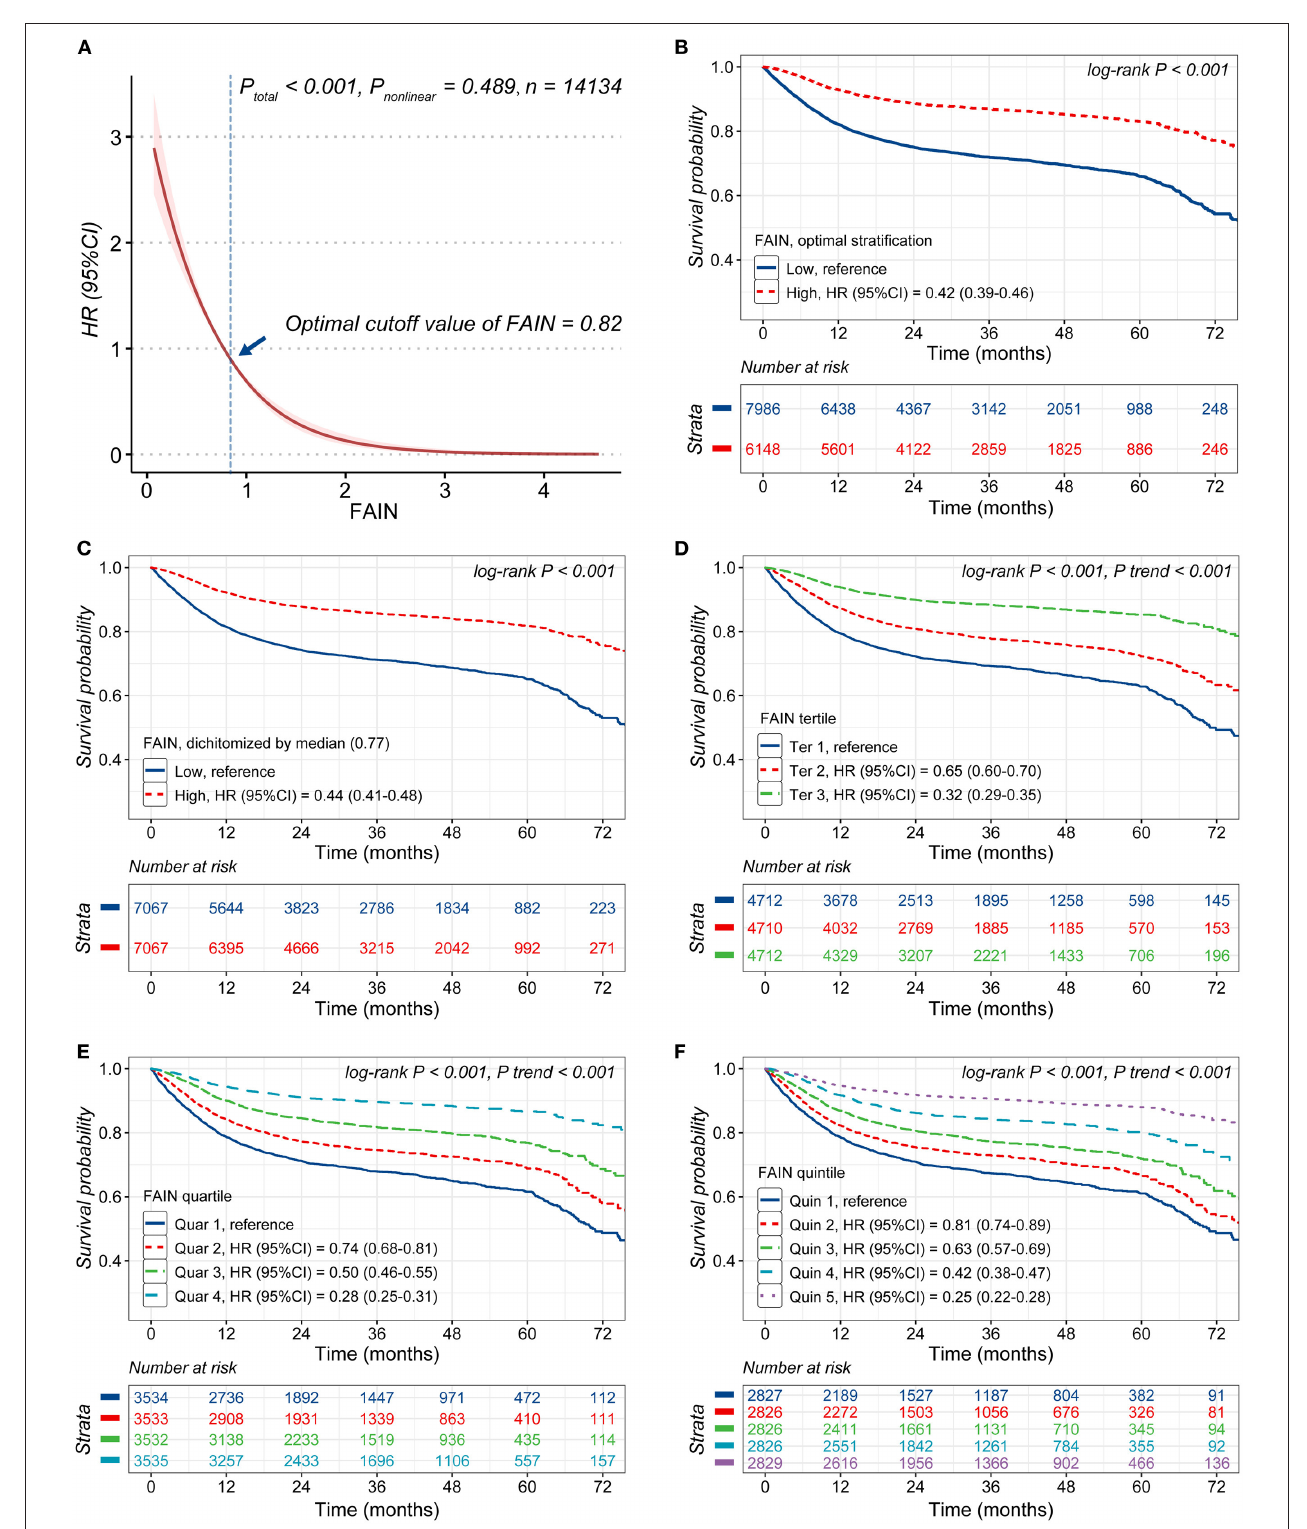
FIGURE 2 | Analysis of the associations of the fat-age-inflammation (FAIN) index with survival. (A) Restricted cubic spine (RCS) analysis of the association of the FAIN with survival. (B) Kaplan-Meier curves stratified by FAIN (dichotomized using the threshold calculated by optimal stratification). (C) Kaplan-Meier curves stratified by the FAIN (dichotomized using the median value). (D) Kaplan-Meier curves stratified by FAIN tertiles. (E) Kaplan-Meier curves stratified by FAIN quartiles. (F) Kaplan-Meier curves stratifi ed by FAIN quintiles.